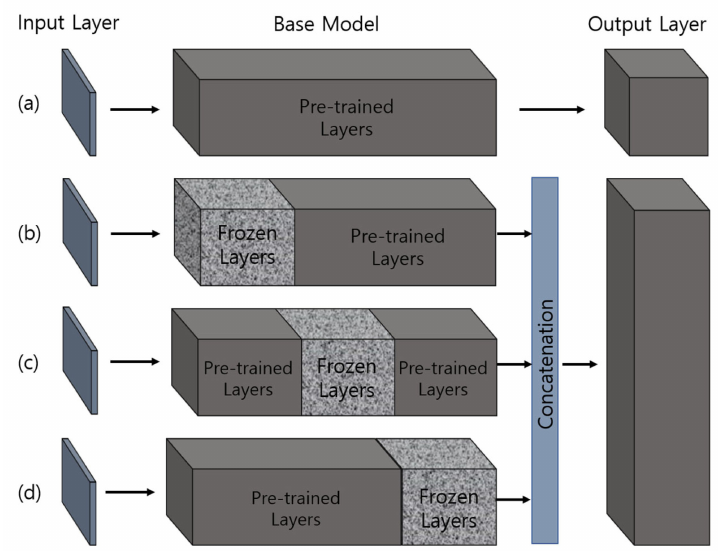
Figure 4. Approaches for training pretrained models based on transfer learning. The weights of pretrained layers in the base models are modified during the learning process, whereas the frozen layers retain their weights (i.e., not modified). ( a ) A basic transfer learning approach, where the pretrained model is loaded and trained using the extracted features. ( b – d ) The proposed transfer learning approach, where three freezing techniques are applied and features from each model are concatenated to perform